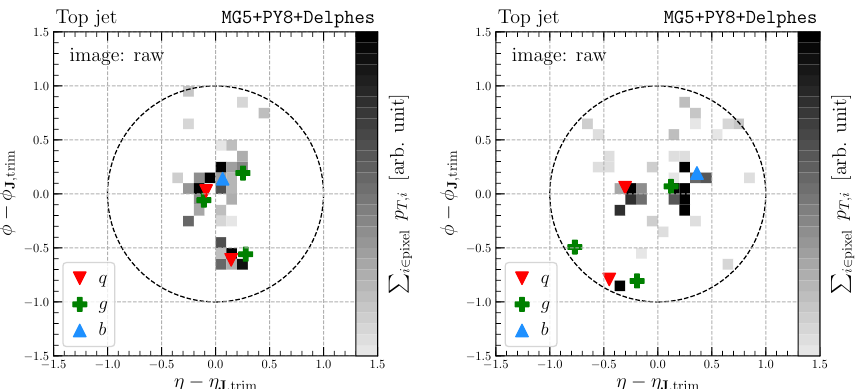
Figure 13. Jets images of top jets that RN